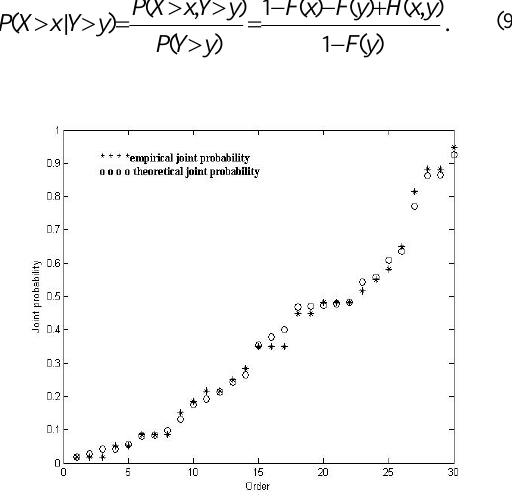
Fig. 1. Comparison of empirical and theoretical joint probability of the AMFMs of Sanmenxia and Huayuankou